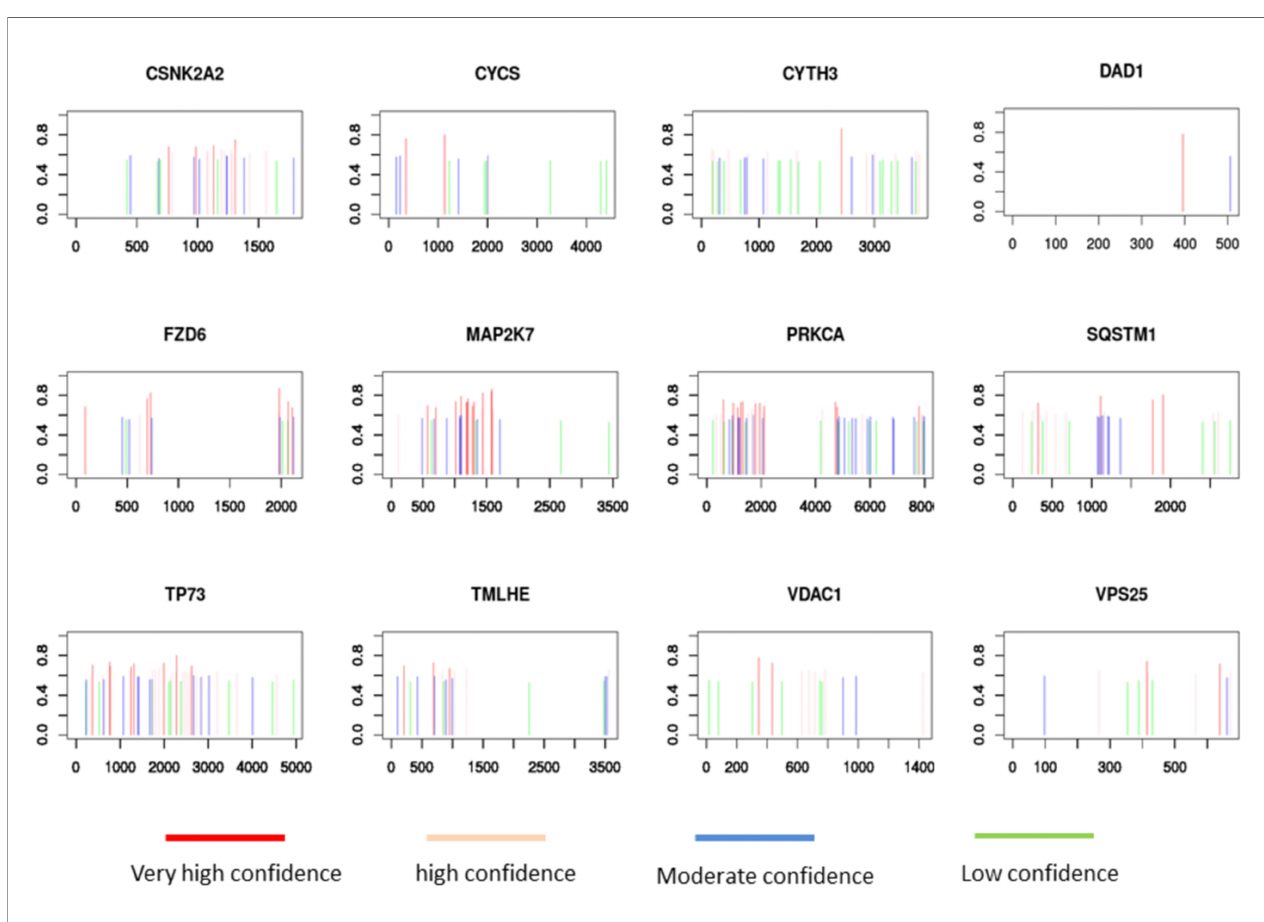
FIGURE 5 | SRAMP analysis of potential m6A methylation modi fi cation sites on 12 m6A regulator-related